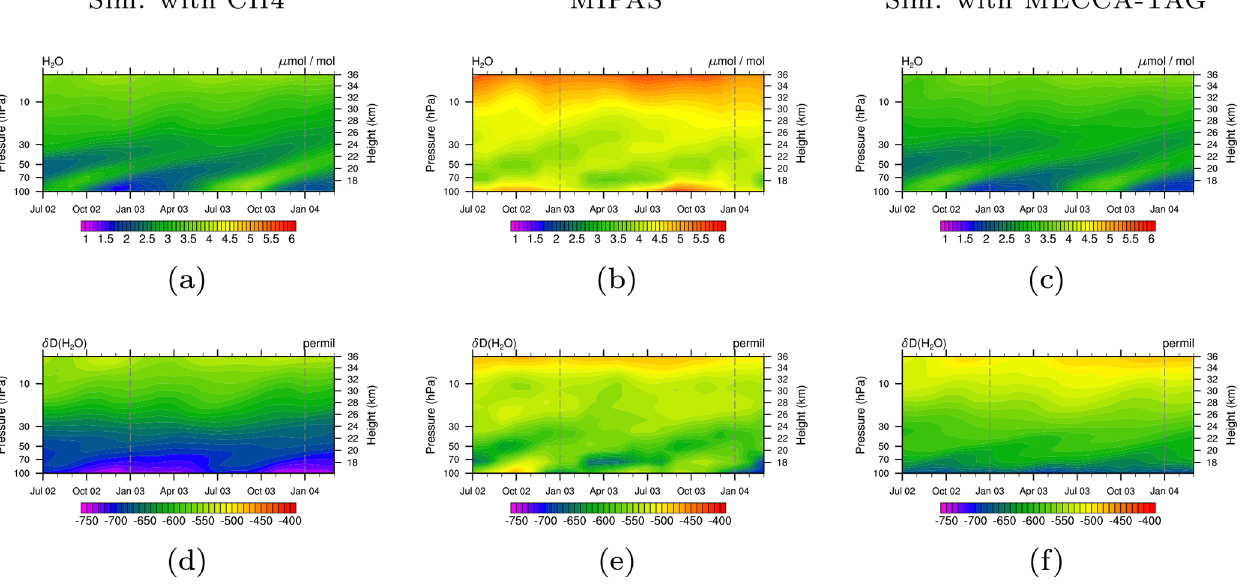
Figure 6. Tropical stratospheric tape recorder signal of H 2 O (a, b, c) and δ D(H 2 O) (d, e, f) in MIPAS data (b, e) and the simulations with the CH4 submodel (a, d) and the MECCA_TAG submodel (c, f) in the time period July 2002 to March 2004. Simulation data are averaged monthly, zonally, and over the tropics between 23 ◦ S–23 ◦ N and are displayed between 100 and 1hPa. The dashed grey lines are included for eye guidance in the comparison of the tape recorder